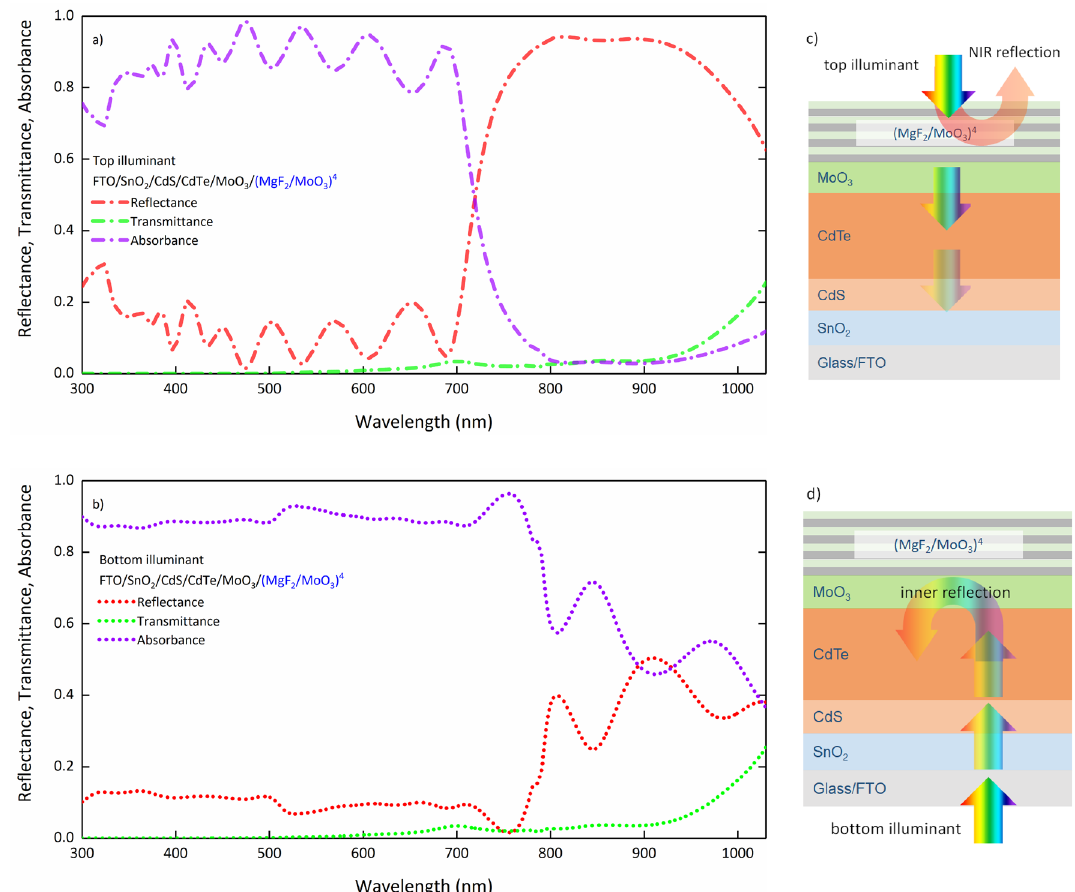
Figure 7. Optical characteristics of FTO/SnO 2 /CdS/CdTe/MoO 3 /(MgF 2 /MoO 3 ) 4 SC under ( a ) top and ( b ) bottom illumination, ( a ) representation of the optical processes occurring in the SC under ( c ) top and bottom